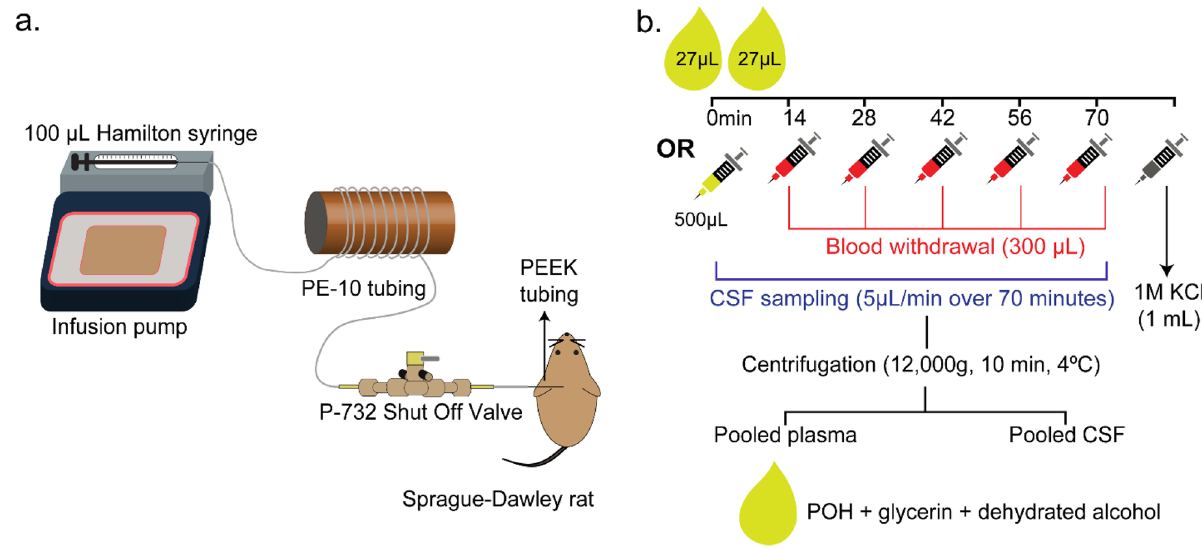
Figure 1. Experimental setup. (a) Surgical setup for intracisternal withdrawal of cerebrospinal fluid. (b) Dosing paradigm for intranasal and intravascular perillyl alcohol (POH) administration experiments. Rats